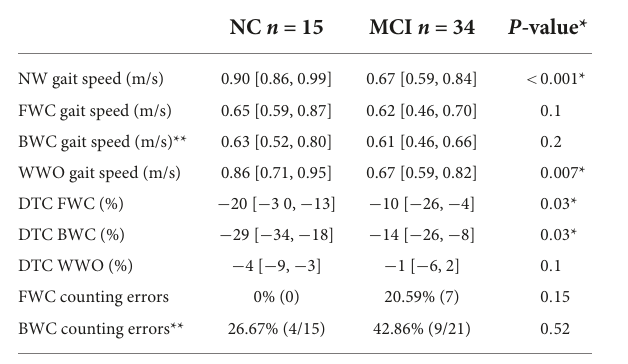
TABLE 2 Behavioral data during CBF monitoring.